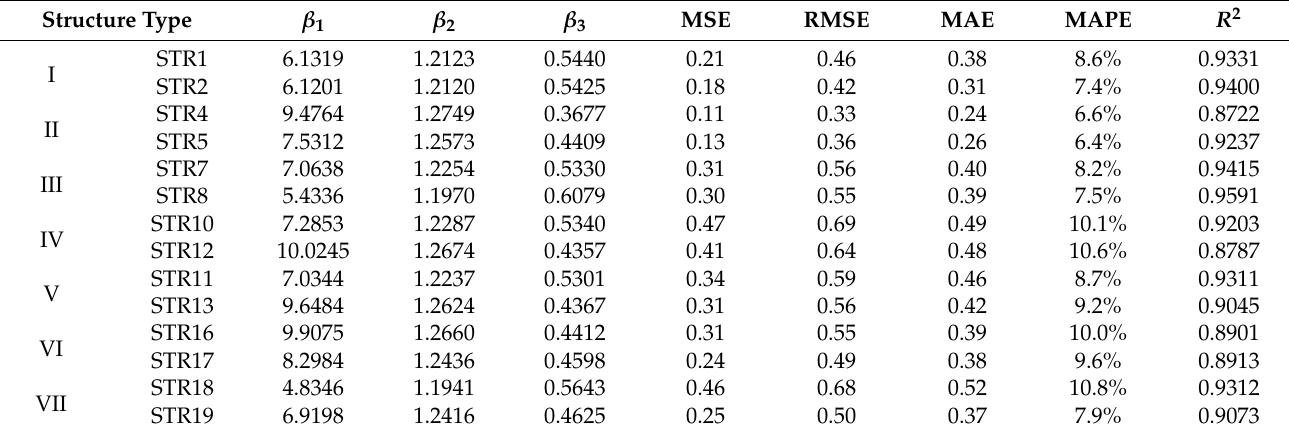
Table 4. Local correction coefficients and errors of rutting